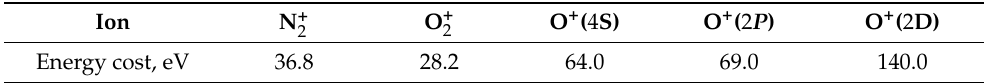
Table 1. Energy cost for different